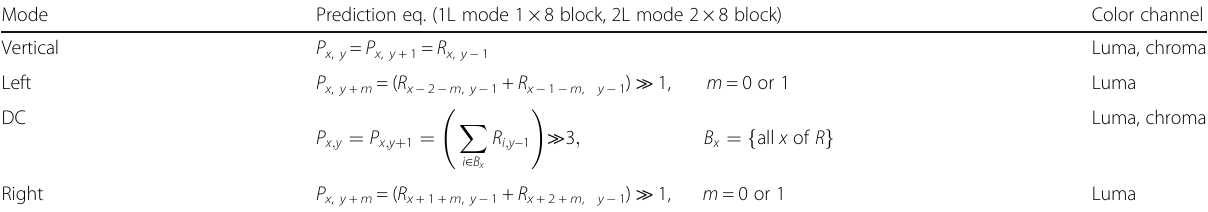
Table 1 Proposed interline prediction